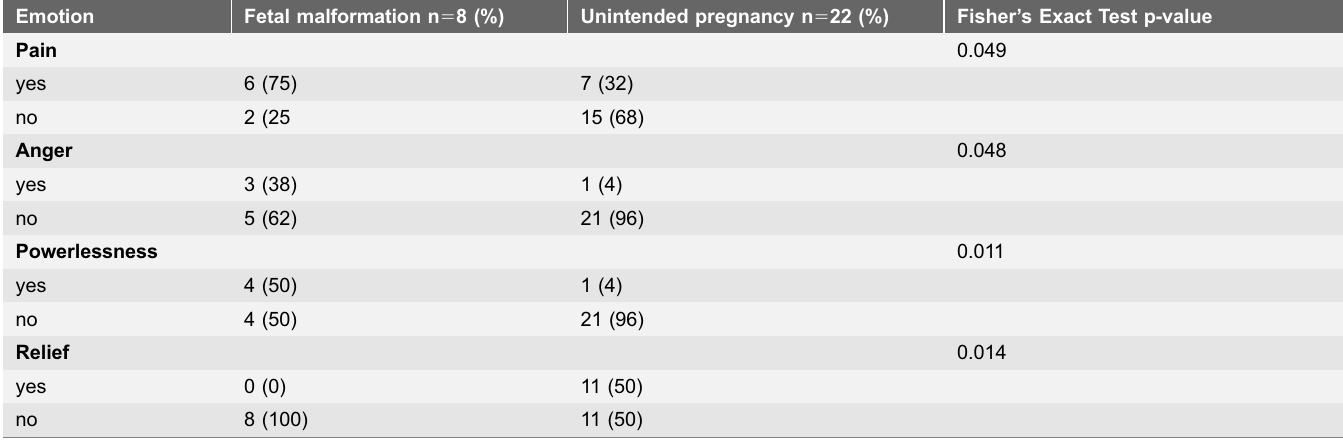
Table 6. Selected words describing emotions prior to the abortion.